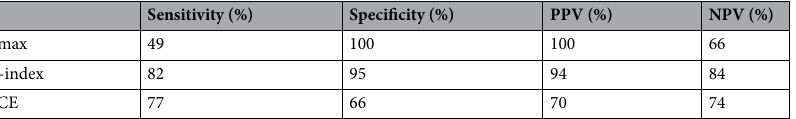
Table 4. The performance of Kmax, D-index and KCE as isolated predictors of KC progression (defined as a significant change in two or more variables). Kmax maximum keratometry, D-Index Belin/Ambrósio D-Index, KCE Keratoconus Enlargement, PPV positive predictive value, NPV negative predictive